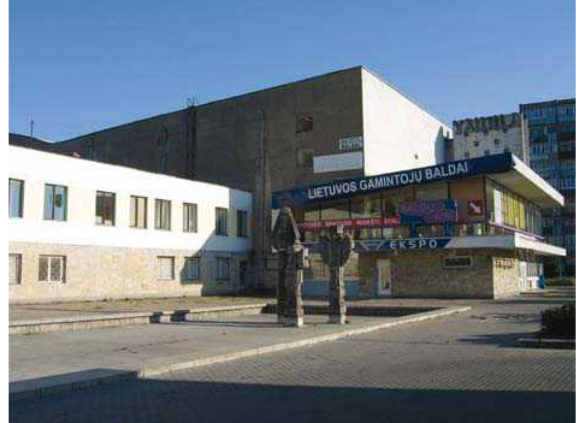
Fig 6. Fragment of Public Center. Arch G. Tiškus et al,